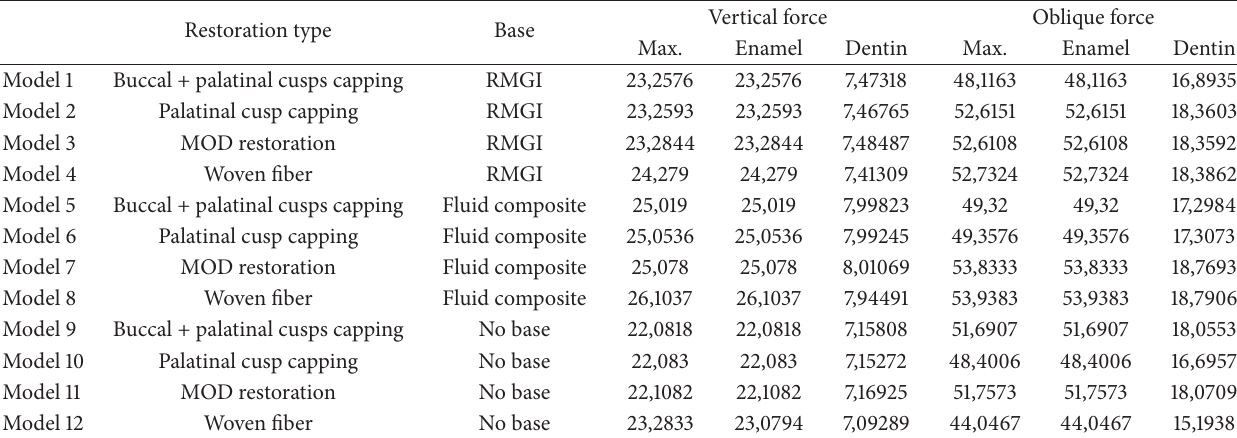
Table 2: Maximum stress values in models to which vertical and oblique forces were